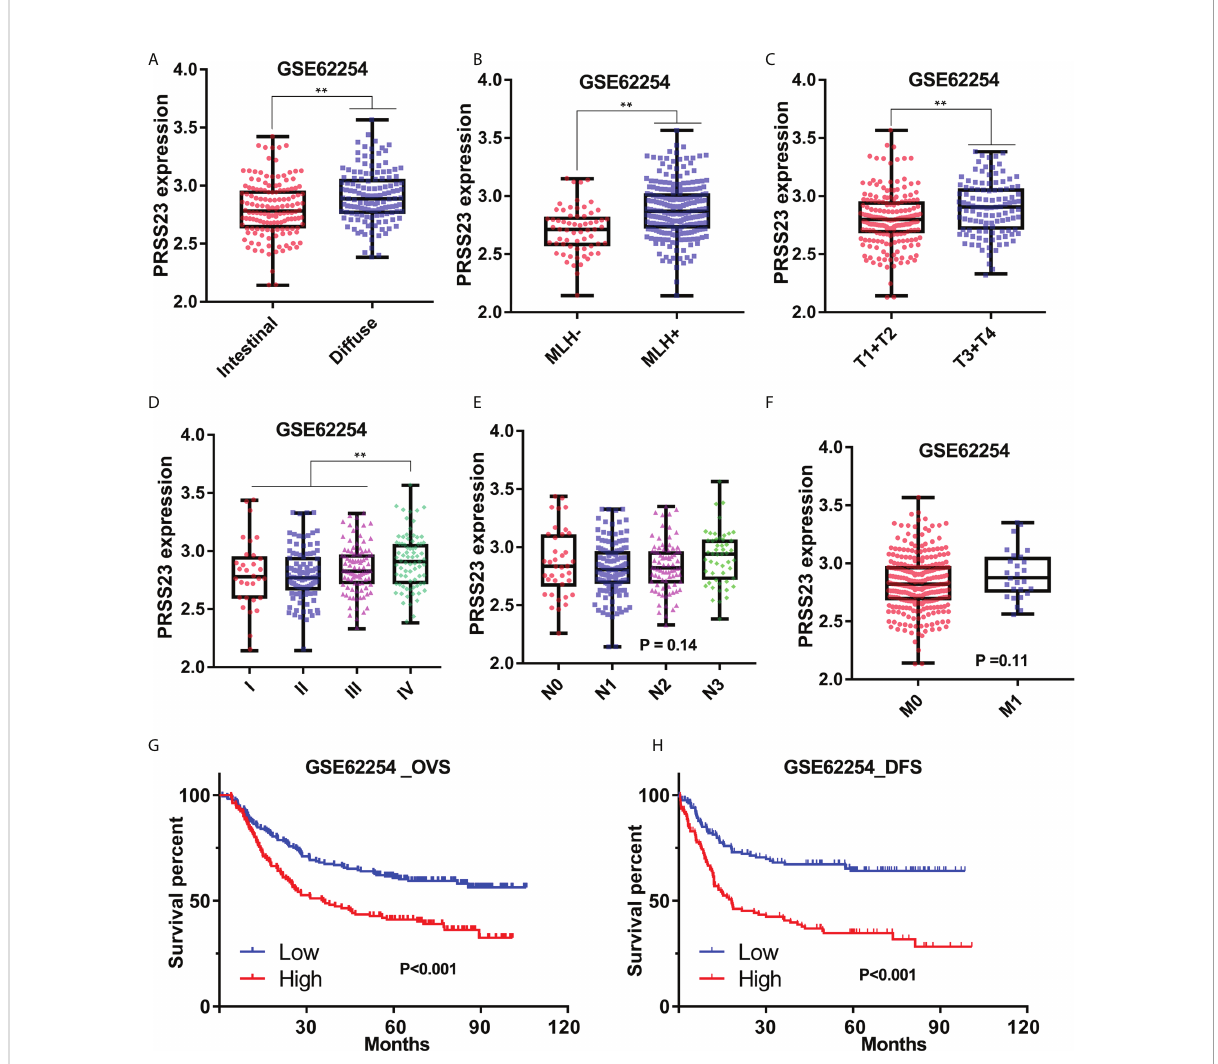
FIGURE 2 The prognostic signi fi cance of PRSS23 overexpression was analyzed in the GC cohort from GSE62254. (A) Differences in PRSS23 expression between intestinal and diffuse tissues of GC. (B) PRSS23 was highly expressed in GC patients with positive MLH1 expression. (C – F) PRSS23 expression level in different TNM-stages and Pathologic stages of GC tissues. (G, H) PRSS23 overexpression predicted shorter overall survival time and disease-free survival time in GC. **, P <